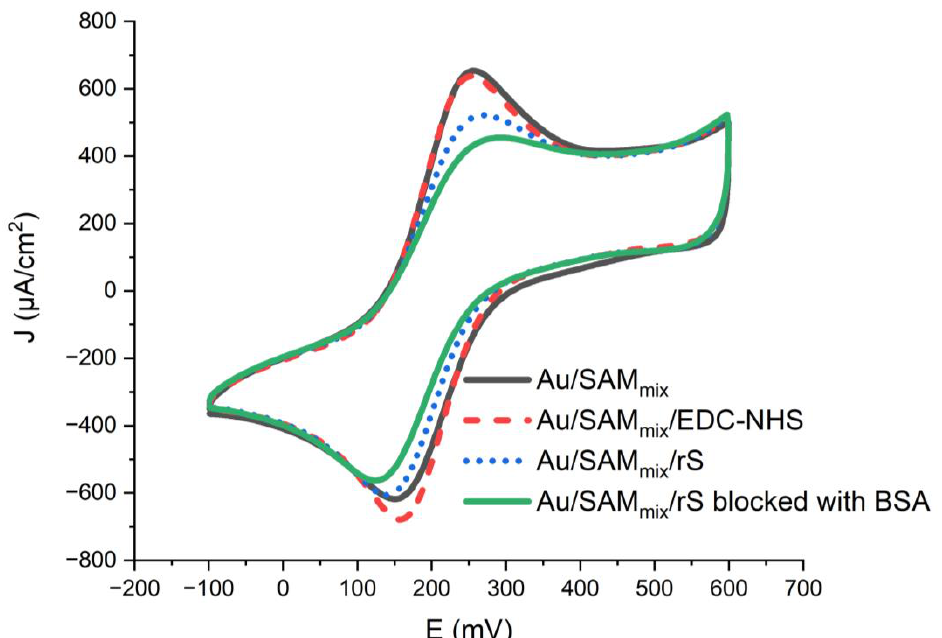
Figure 3. Cyclic voltammograms of Au/SAM mix (black, solid line), Au/SAM mix /EDC-NHS (red, dashed line), Au/SAM mix /rS (blue, dotted line), and Au/SAM mix /rS electrode blocked with BSA (green, solid line) in PBS (pH 7.4) with 2 mM of [Fe(CN) 6 ] 3− and 2 mM of [Fe(CN) 6 ] 4− as a redox probe.